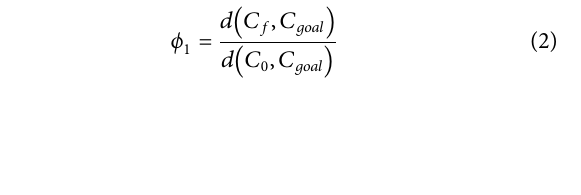
TABLE 1 | Muscles included in the model, their acronyms and their respective maximum isometric strengths for the 0% strength de fi cit